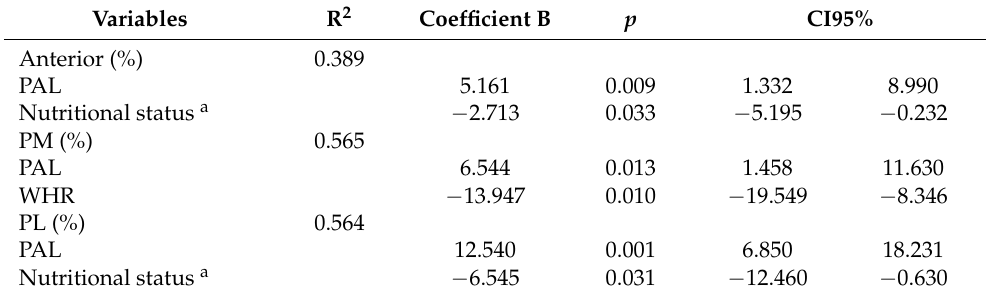
Table 5. Significant multiple linear regression models obtained for dynamic postural